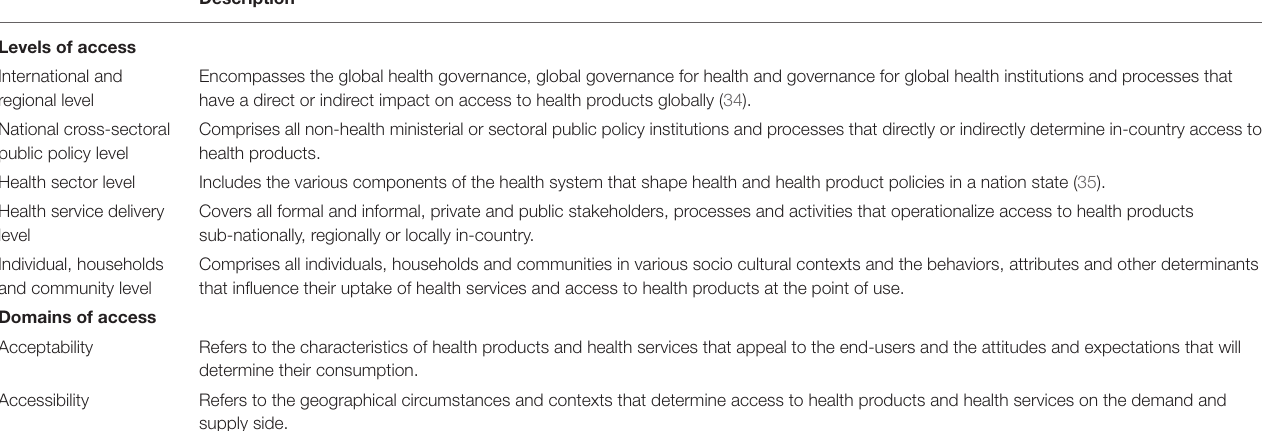
TABLE 1 | Framework & typology of levels and domains of access adapted from Bigdeli et al. (33).